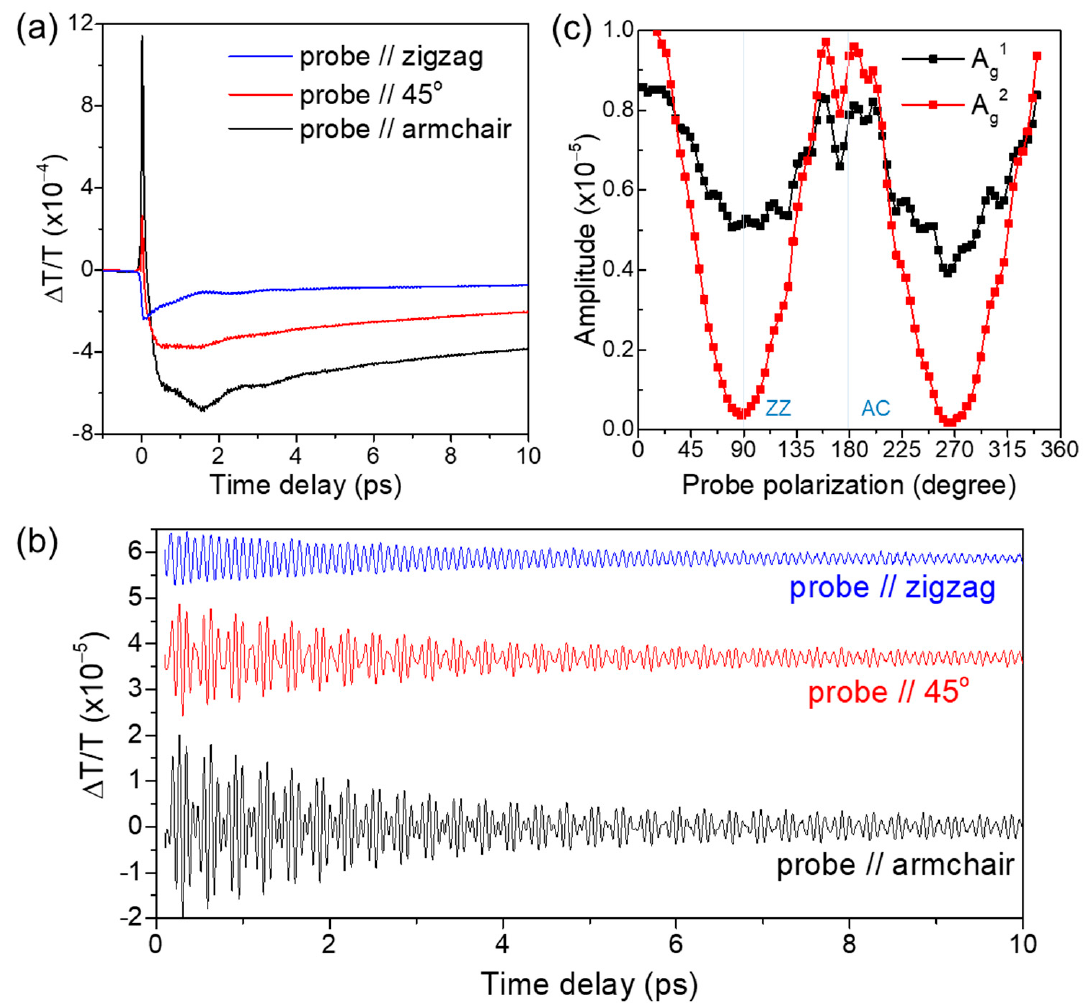
Figure 3. ( a ) Time-resolved TT signals of sample A at different probe polarizations with the pump polarization fixed along the AC axis. ( b ) CP oscillations extracted from the TT signals at different probe polarizations. ( c ) A g1 and A g2 mode CP amplitudes as a function of probe polarization.